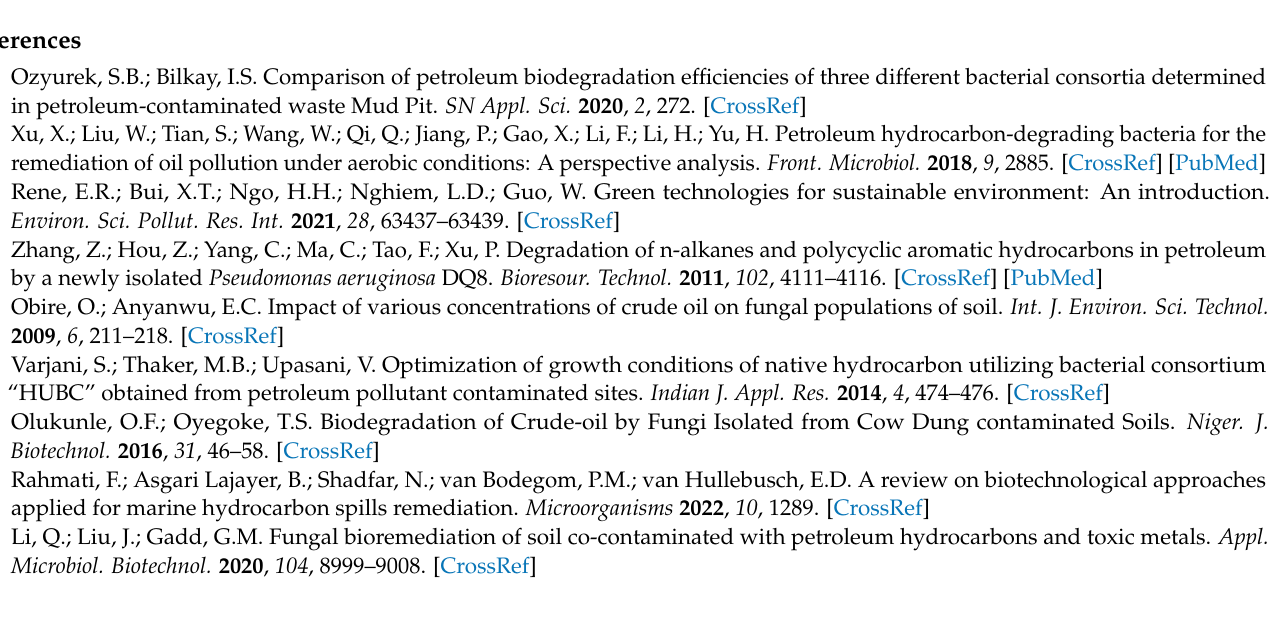
mentary Figure S3: Biodegradation ability of isolated fungi cultured on Liquid MSM media supplied with 1% of various oil sources and incubated in a shaker at 25 ◦ C for 30 days. (A) F. verticillioides , (B) F. proliferatum , (C) F. oxysporum . Supplementary Figure S4: DCPIP assay. Liquid media (MSM) containing 1% of various oil sources; 0.1% ( v / v ) of Tween 80, 0.6 mg/mL of redox indicator (DCPIP) as a control and incubated in a shaker at 25 ◦ C for 15 days. (A) control (no fungi), (B) F. verticillioides , (C) F. proliferatum , (D) F. oxysporum. Supplementary Figure S5: Emulsification test. The emulsification activity was measured to test the ability of the CFSs produced by different Fusarium isolates to emulsify different